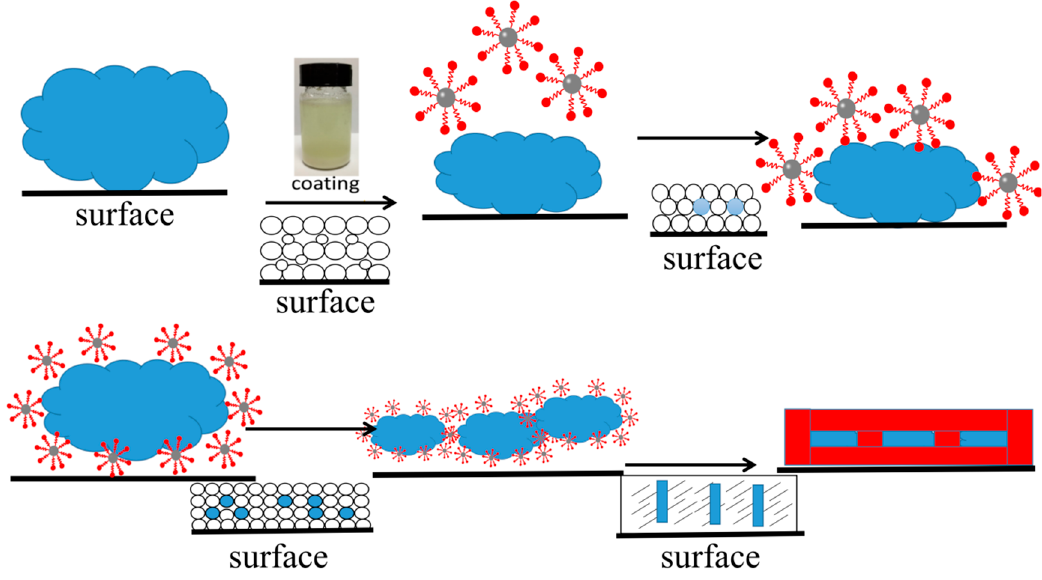
Figure 9. The activity of the decontaminant on larger particles.